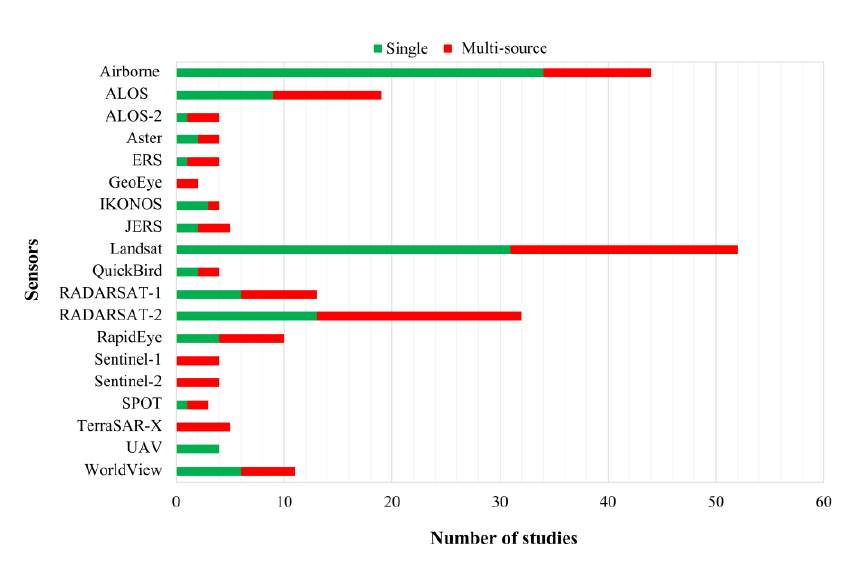
Figure 14. Application of various sensors in wetland classification studies. The green bar represents the number of studies that use only the data from a single sensor. The red bar represents the number of studies that use the data from a sensor in combination with other data sources.